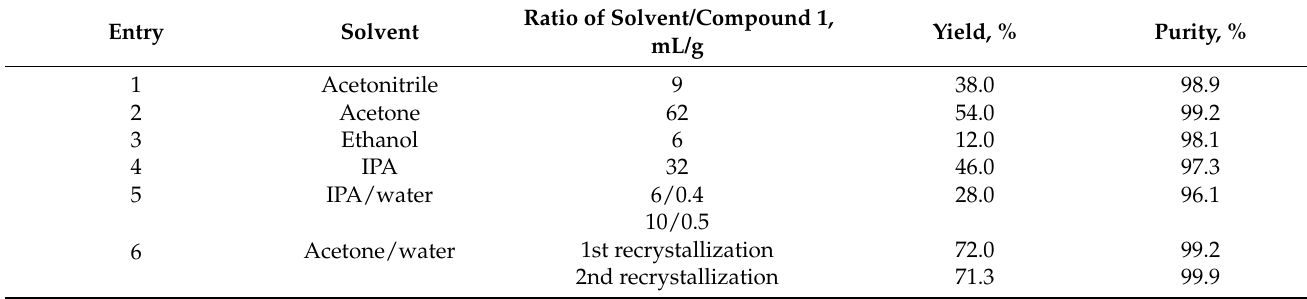
Table 5. Effects of solvents on yield and quality of 1 when